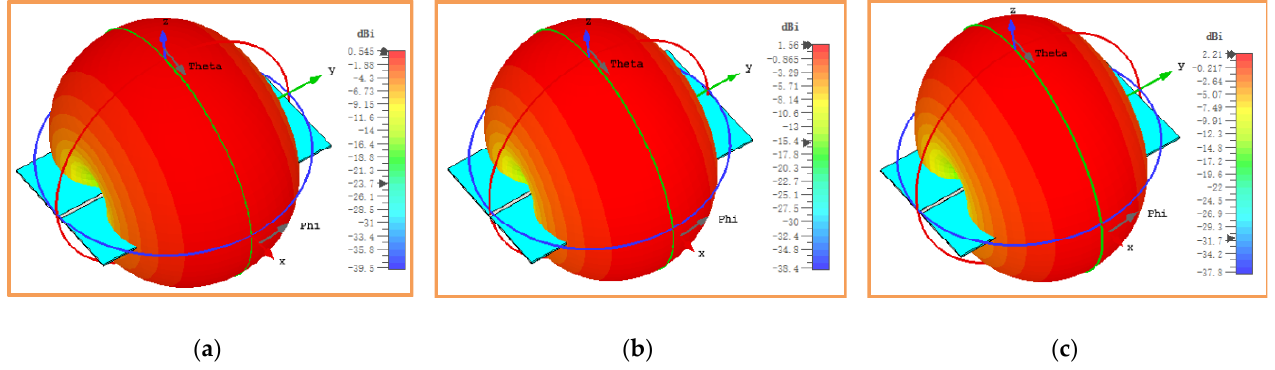
Figure 10. Simulated 3D radiation pattern of states 001 ( a ), 101 ( b ), and 111 ( c ) at 1.28 GHz, 1.60 GHz, and 1.88 GHz, respectively.